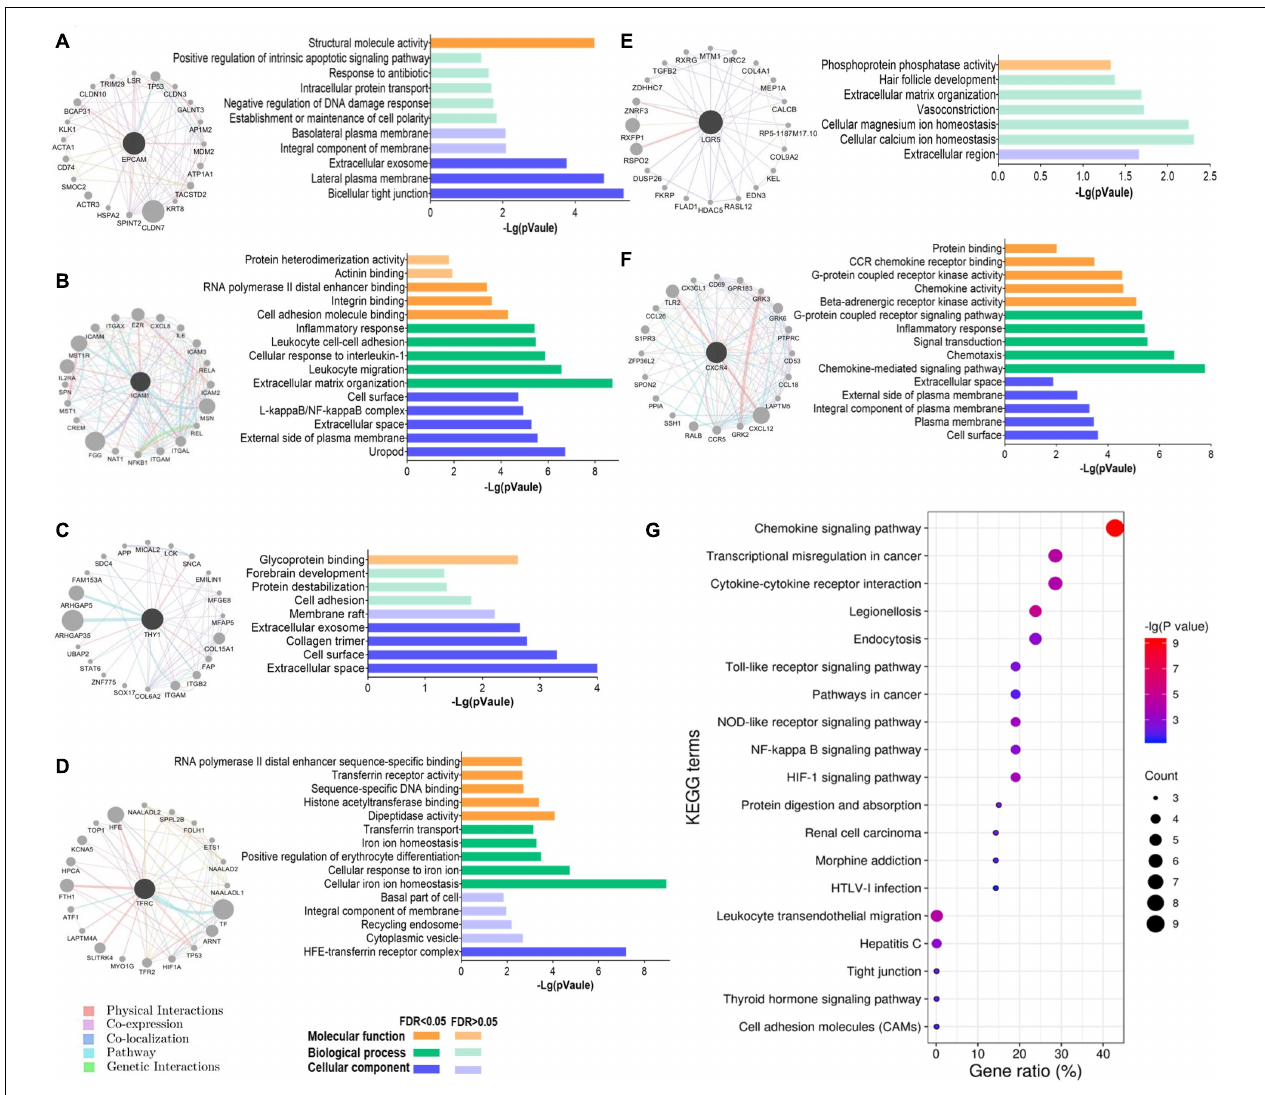
FIGURE 6 | Functions of the interactive genes of GCSC markers. The gene interaction network and its GO functional annotation of (A) EPCAM , (B) ICAM1 , (C) THY1 , (D) TFRC , (E) LGR5 , and (F) CXCR4 . Distinct colors of the edges in gene interaction networks represent distinct interactions, including physical interactions, co-expression, co-localization, pathway, and genetic interactions (GeneMANIA). (G) All the significantly enriched KEGG pathway terms of the six gene interaction networks are shown. The size of a bubble indicates the number of genes enriched for a pathway term; a redder color of a bubble represents a greater significance of the corresponding